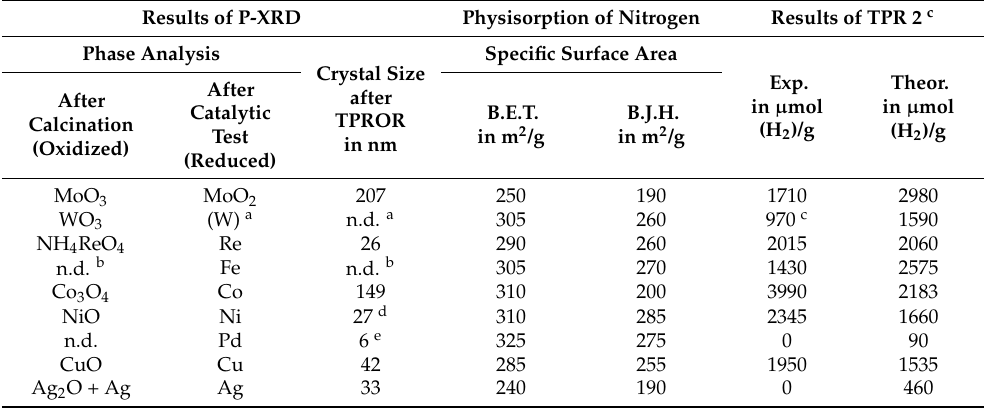
Table 1. Summary of the results of the nitrogen physisorption measurements and the P-XRD mea- surements of the different metal catalysts. The crystallite size was calculated based on the powder diffractograms of the catalysts after TPROR measurement from TPR 1, TPO and TPR 2. Results of